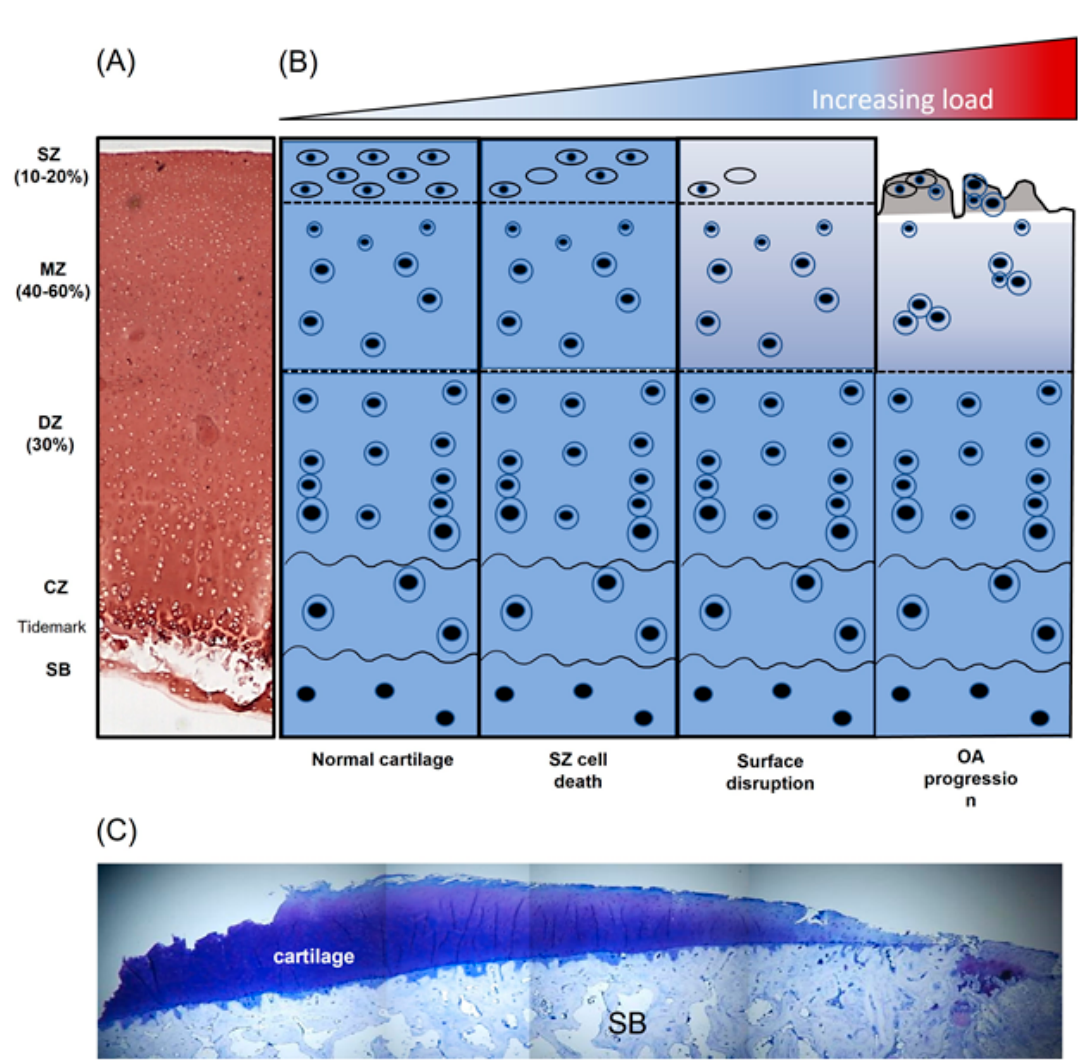
Figure 2. Diagrammatic overview demonstrating the influence of non-physiological load on articular cartilage composition and structure. ( A ) Safranin-O stained section of immature bovine articular cartilage, ( B ) schematic representation of articular chondrocyte morphology and cartilage disruption with increasing pathological load and ( C ) toluidine-blue -stained section of knee articular cartilage from a patient with end-stage osteoarthritis (OA) (adapted from [14]). SZ, superficial zone; MZ, middle zone; DZ, deep zone; CZ, calcified zone; SB, subchondral bone.